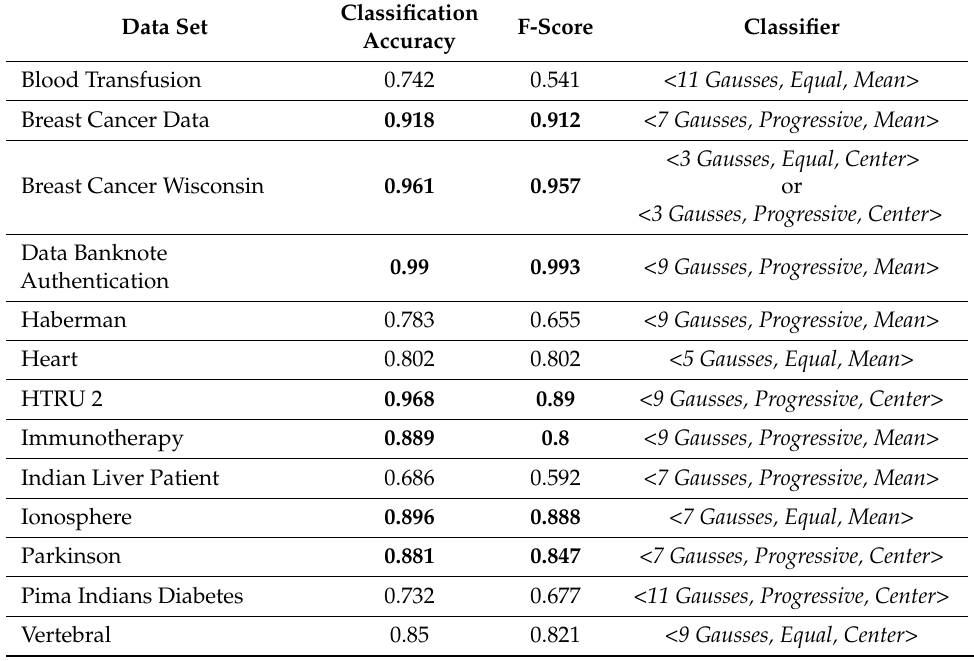
Table 6. Evaluation of the method proposed.